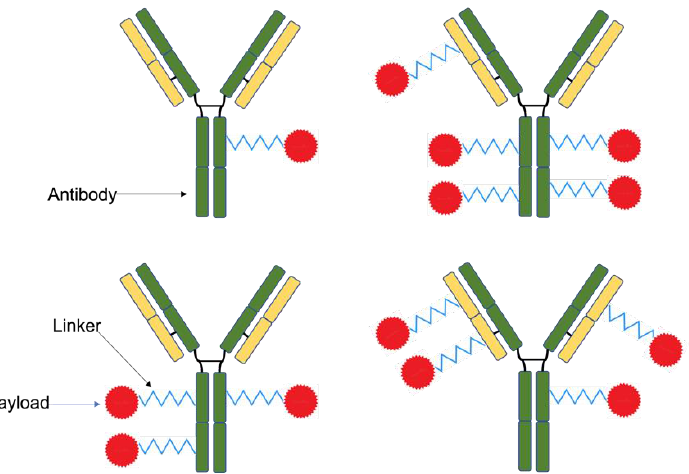
Figure 2. Heterogenous ADCs produced using conventional conjugation methods. Linking between the payload molecule and the antibody can happen across any of the available residues. Therefore, the drug-to-antibody ratio and the ADC configuration can differ. It is difficult to control this using conventional conjugation methods, and the properties of the conjugates vary as a result.